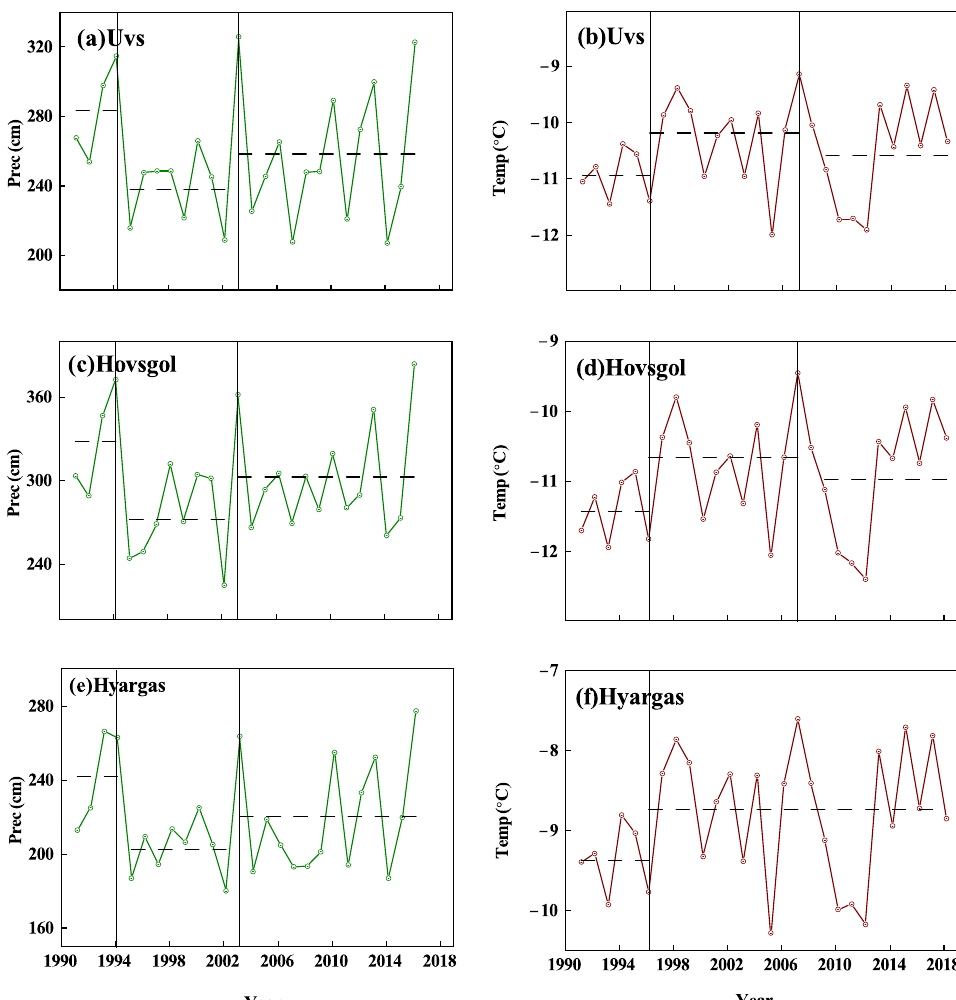
Figure 8. The significant regime shift in time series of precipitation (green line, left panel ) and temperature (red line, right panel ) over three lakes in the Mongolian Plateau: vertical lines represent regime shift years and horizontal dash lines represent the mean value of each